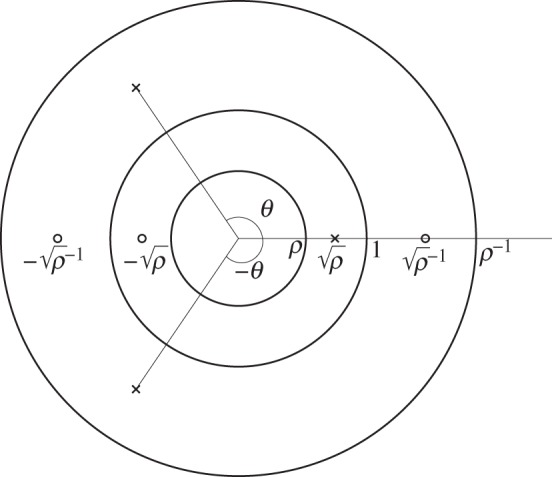
Locations of the three poles (crosses) and three zeros (small circles) for the conformal mapping (3.1). In the annulus ρ<|ζ|<1, which is the pre-image of the elastic body, the mapping has a pole at ρ and a zero at −ρ. It also has two simple poles, at ρ−1 e±iθ, in the unphysical annulus 1<|ζ|<ρ−1 as well as two simple zeros at ±ρ−1.